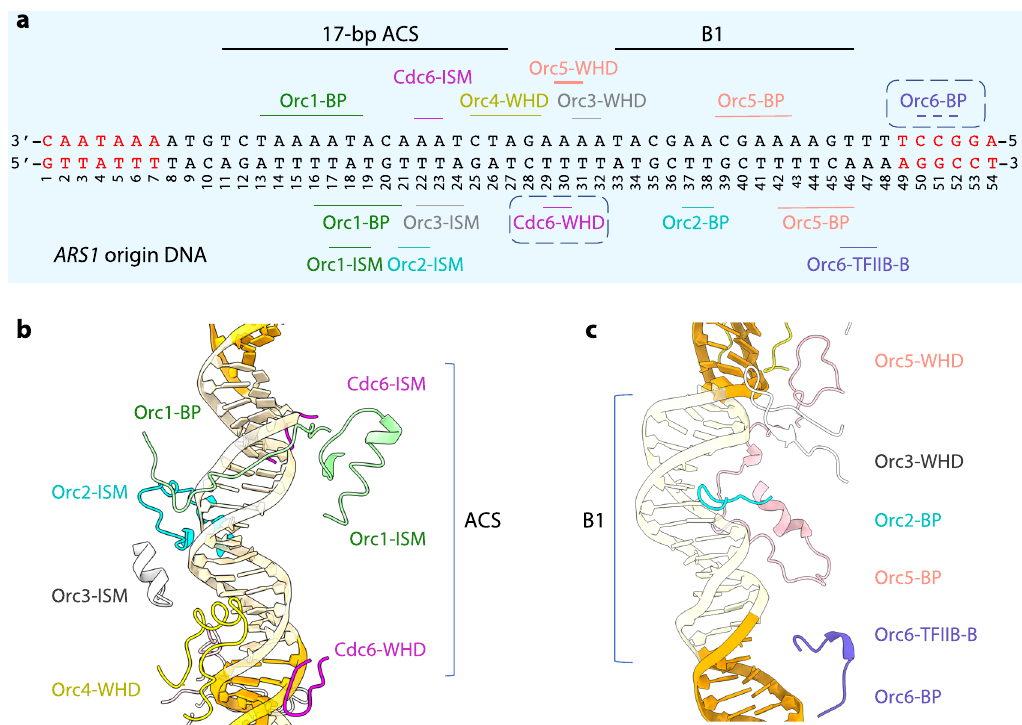
Fig. 2 The footprint of ORC – Cdc6 on the ARS1 origin DNA. a The DNA-binding modules in each subunit are labeled around the DNA sequence: the initiator-speci fi c motif (ISM) of the AAA + domains, the β -hairpin or/and HTH-motif of the WHD domain, and the basic residue patch (BP). Nucleotides in red are the extended footprint in ORC – Cdc6 relative to ORC alone. b Structure of the DNA-binding modules around the ACS element. c Structures of DNA- binding modules around the B1 element of the origin